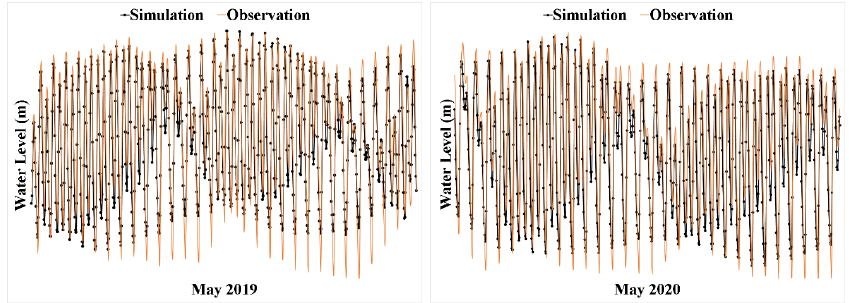
Figure A1. Comparison of simulated and observed water levels at the Long Xuyen station in the dry season 2019.